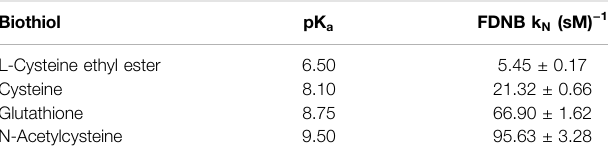
TABLE 2 | Nucleophilic rate constant values for the reaction between FDNB with biothiol series in aqueous media at 25 ° C. Biothiol pK a FDNB k N (sM) − 1